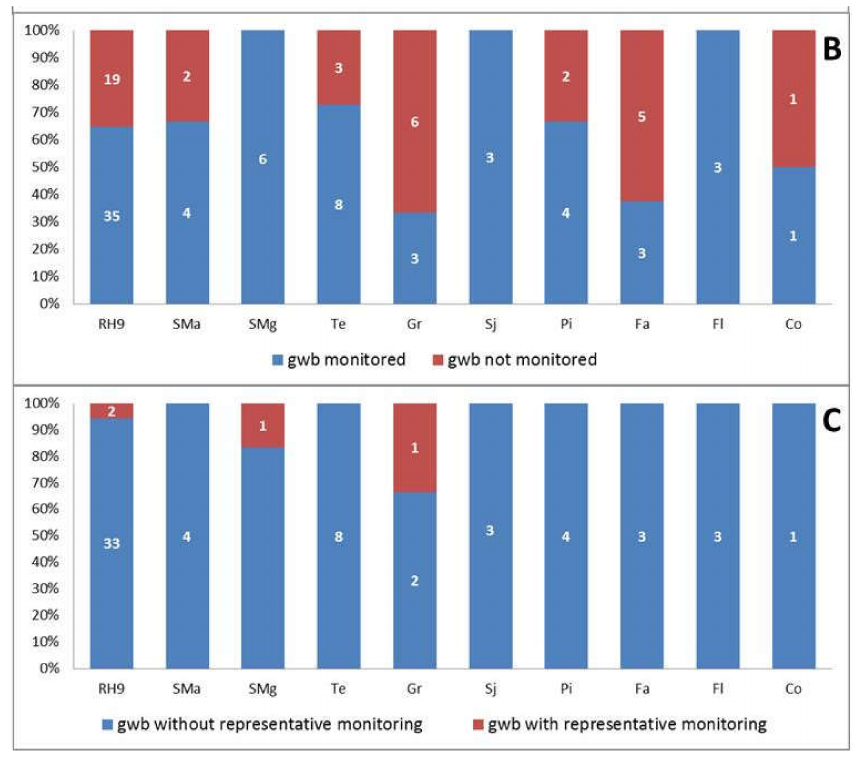
Figure 6. ( A ) The number of springs and drilled wells being monitored; ( B ) the number of groundwater bodies with chemical monitoring; and ( C ) the number of groundwater bodies with representative monitoring network for chemical